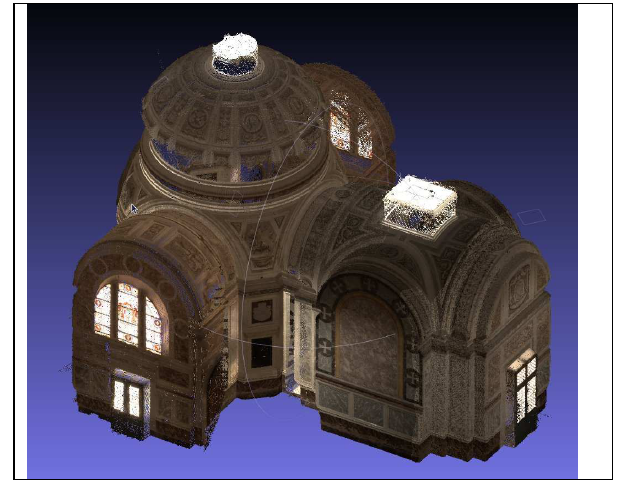
Figure 1. .Modelisation of chapelle imperiale, ajacio. The figure 1 represent a modelization of a chapel, realized with around a hundred images aquired with D5-Mark2 and 15mm fish-eye. This modelization was made by a trainee of MAP Gamsau while developing the interface described in (Godet